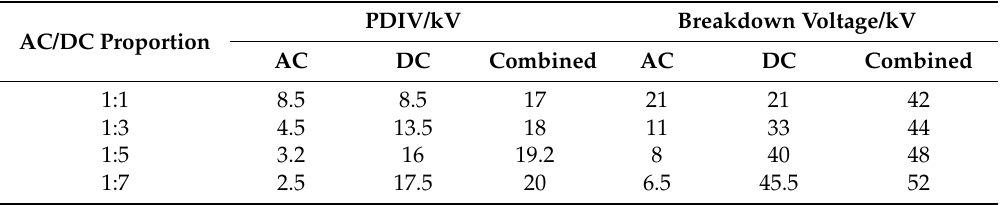
Table 1. Relationship between PDIV and breakdown voltage and AC/DC proportions.